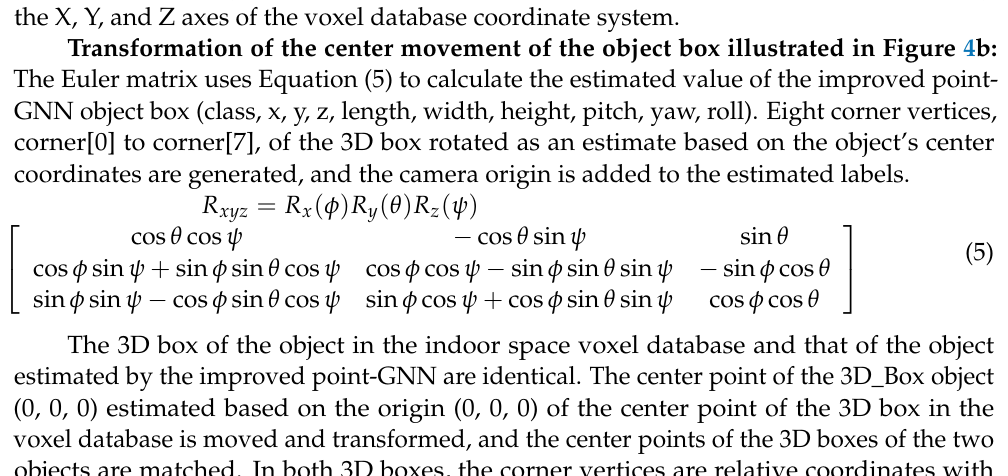
Figure 4. Translate and rotate the three-dimensional (3D) box center point of an object with voxel database coordinates.